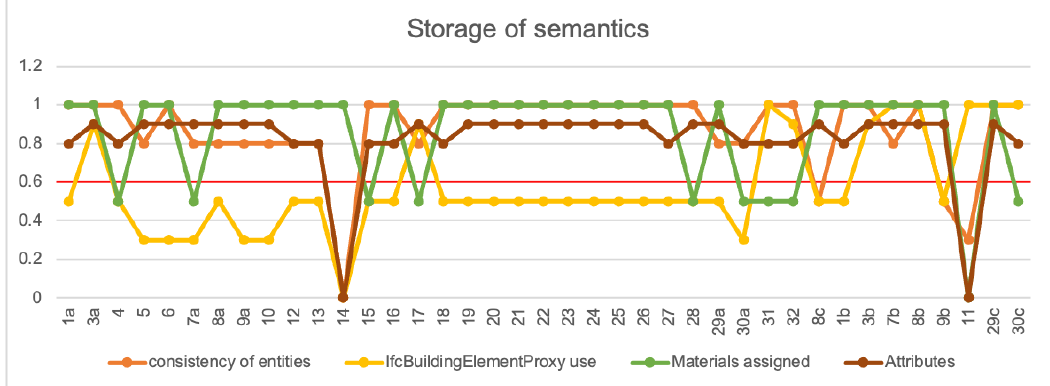
Figure 4. Graph representing the scores assigned to the considered four semantics aspects. The red line indicates the 0.6 score, minimum